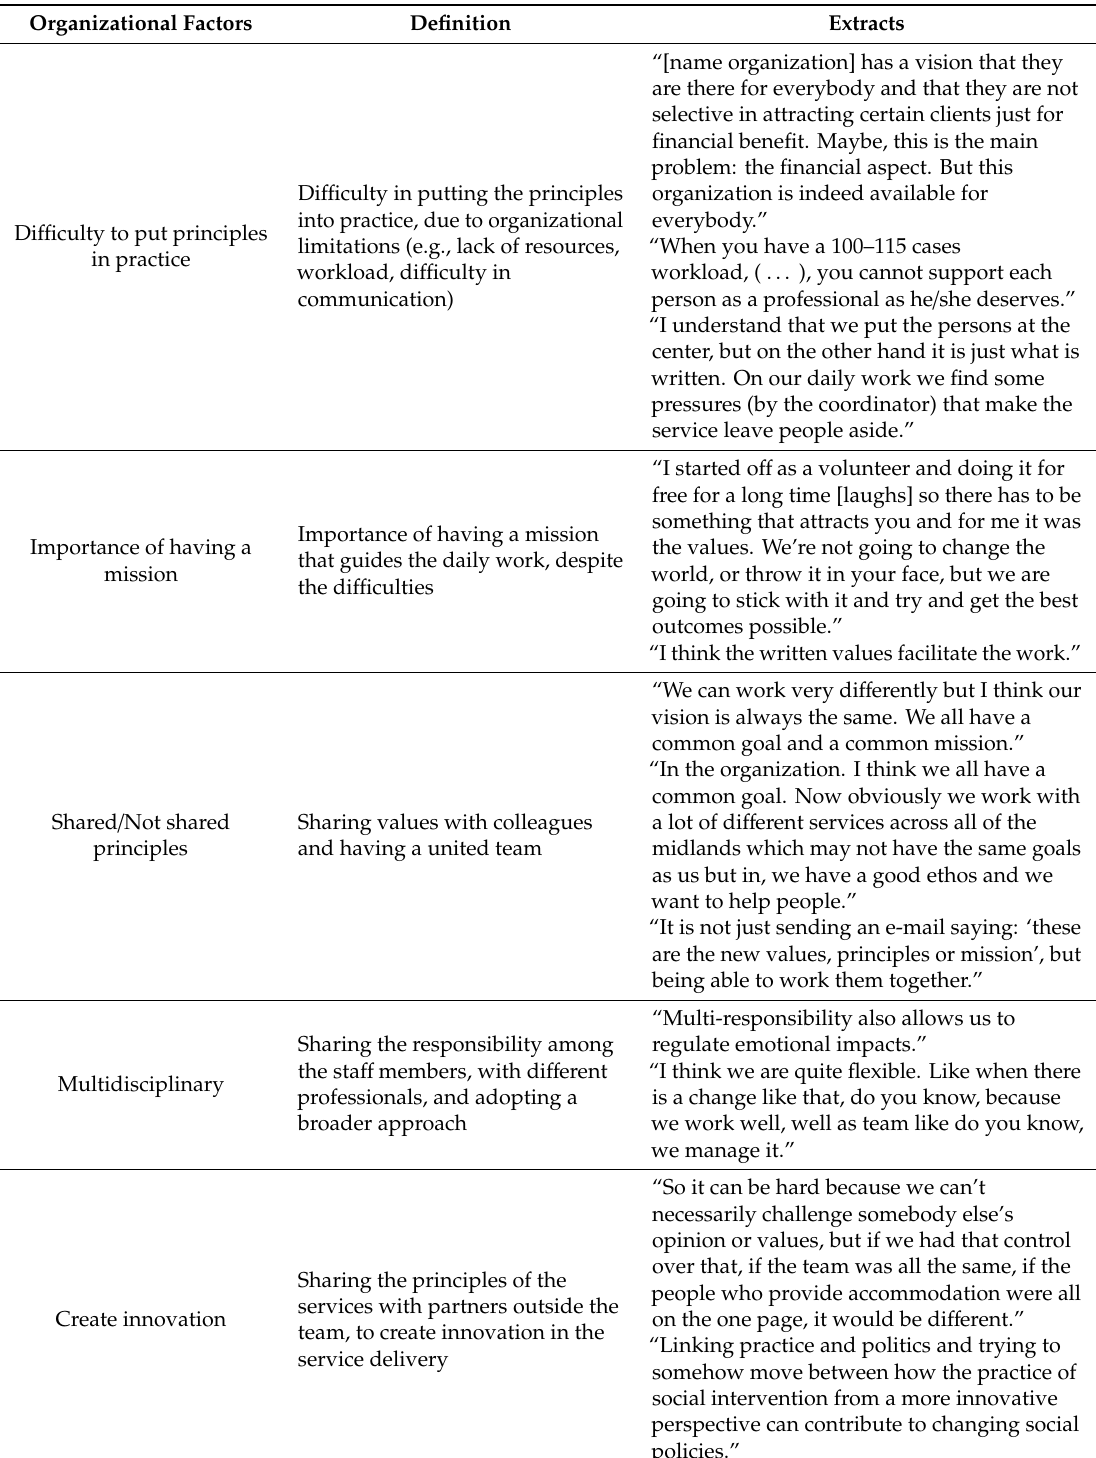
Table 3. Organizational factors relating to the principles of providers working with people experiencing